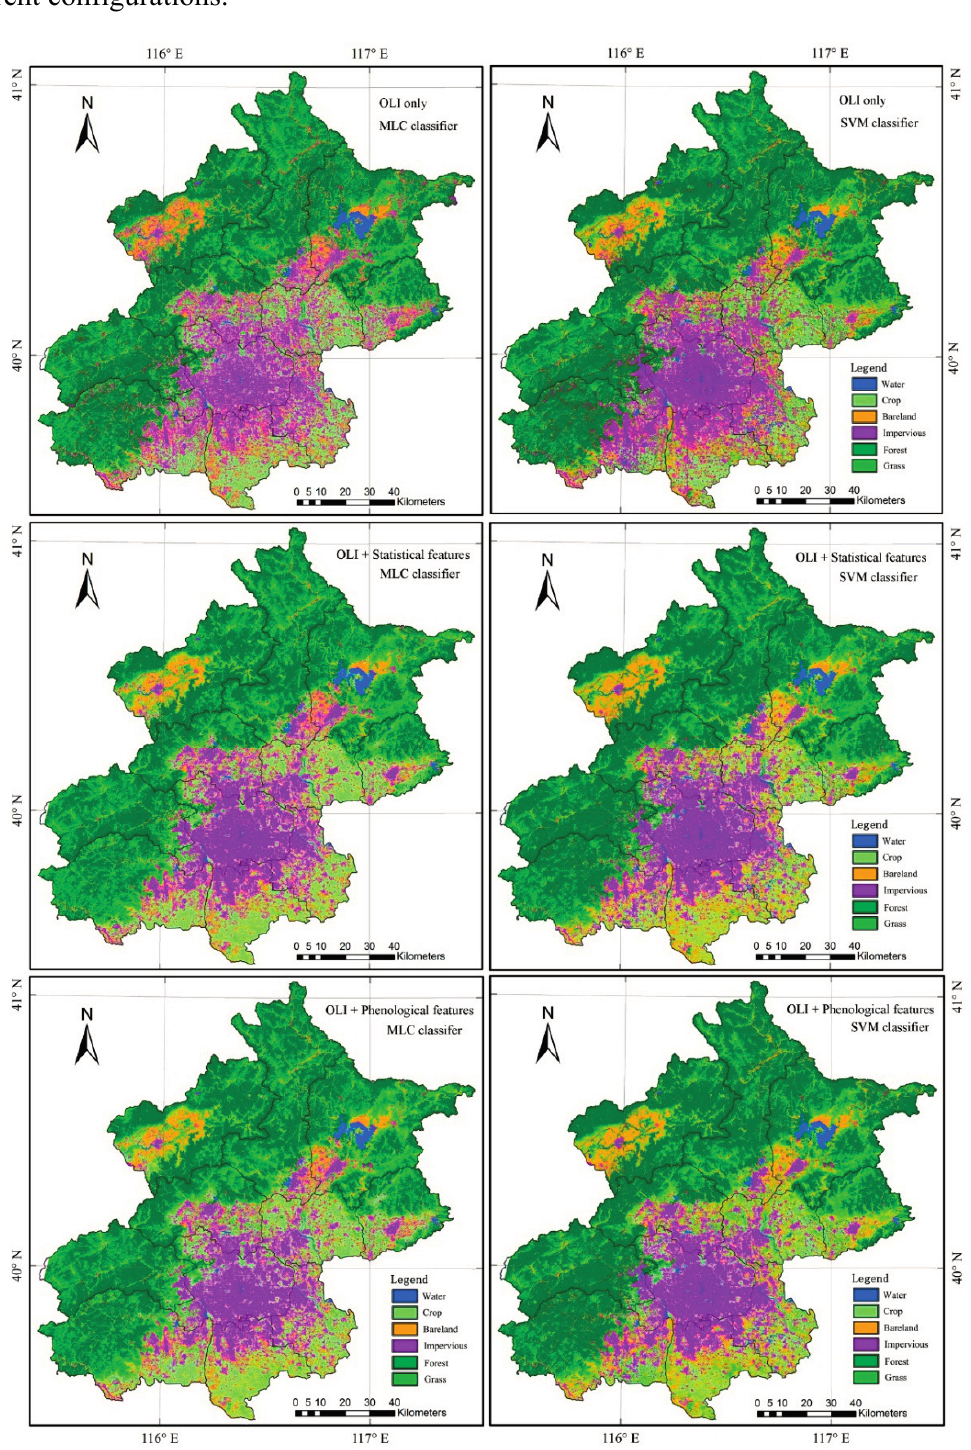
Figure 3. Land cover classification results of MLC and SVM classifiers with different